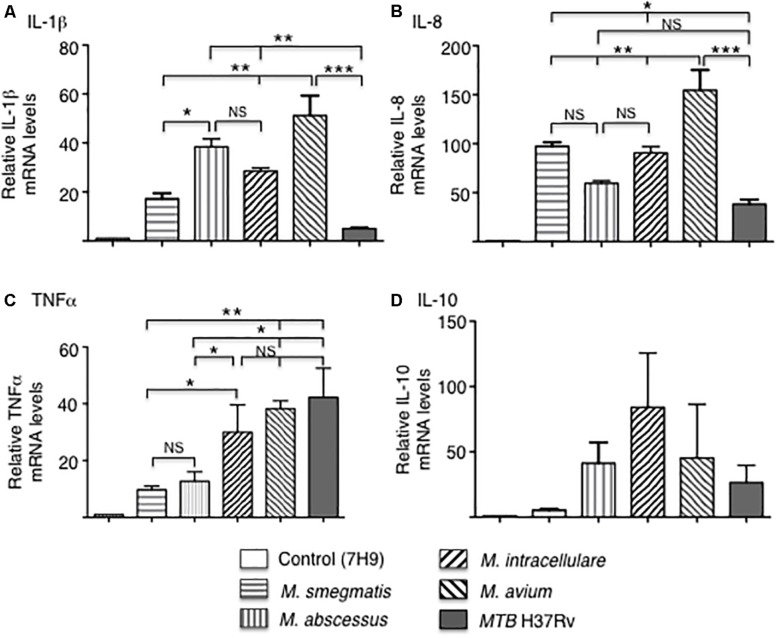
Cytokine gene expression by THP-1 cells infected with different mycobacterial species. Quantitative mRNA expression of (A) IL-1β, (B) IL-8, (C) TNF-α, and (D) IL-10 were determined by qRT-PCR after infection of the indicated mycobacteria for 18 h. GAPDH was used as an endogenous control in the comparative ΔΔCt method. Data shown are mean ± SEM of three independent experiments. *p < 0.05, **p < 0.01, ***p < 0.001, NS, not significant. MOI of 10 mycobacteria:1 macrophage.